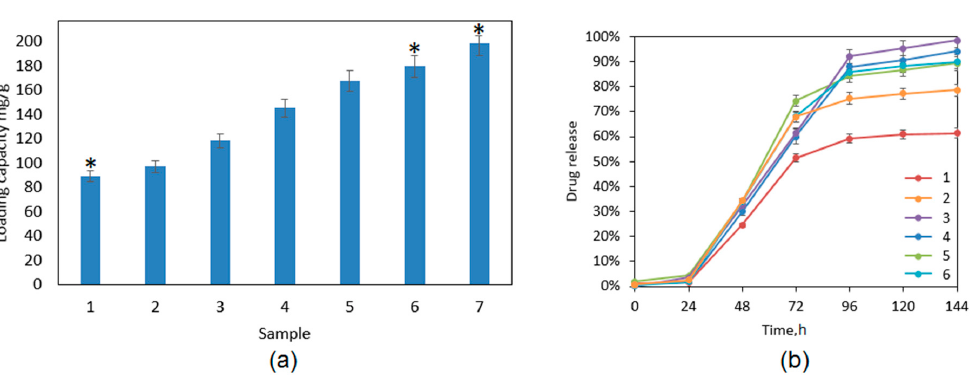
Figure 11. ( a ) Drug loading capacity: (1) hydrogel; (2) CS-ZnO-1; (3) CS-ZnO-2; (4) CS-ZnO-3; (5) CS-ZnO-4; (6) CS-ZnO-5; and (7) CS-ZnO-6. ( b ) Cannabidiol release profile in time (six days): (1) hydrogel; (2) CS-ZnO-1; (3) CS-ZnO-2; (4) CS-ZnO-3; (5) CS-ZnO-4; and (6) CS-ZnO-5. (* p < 0.05).